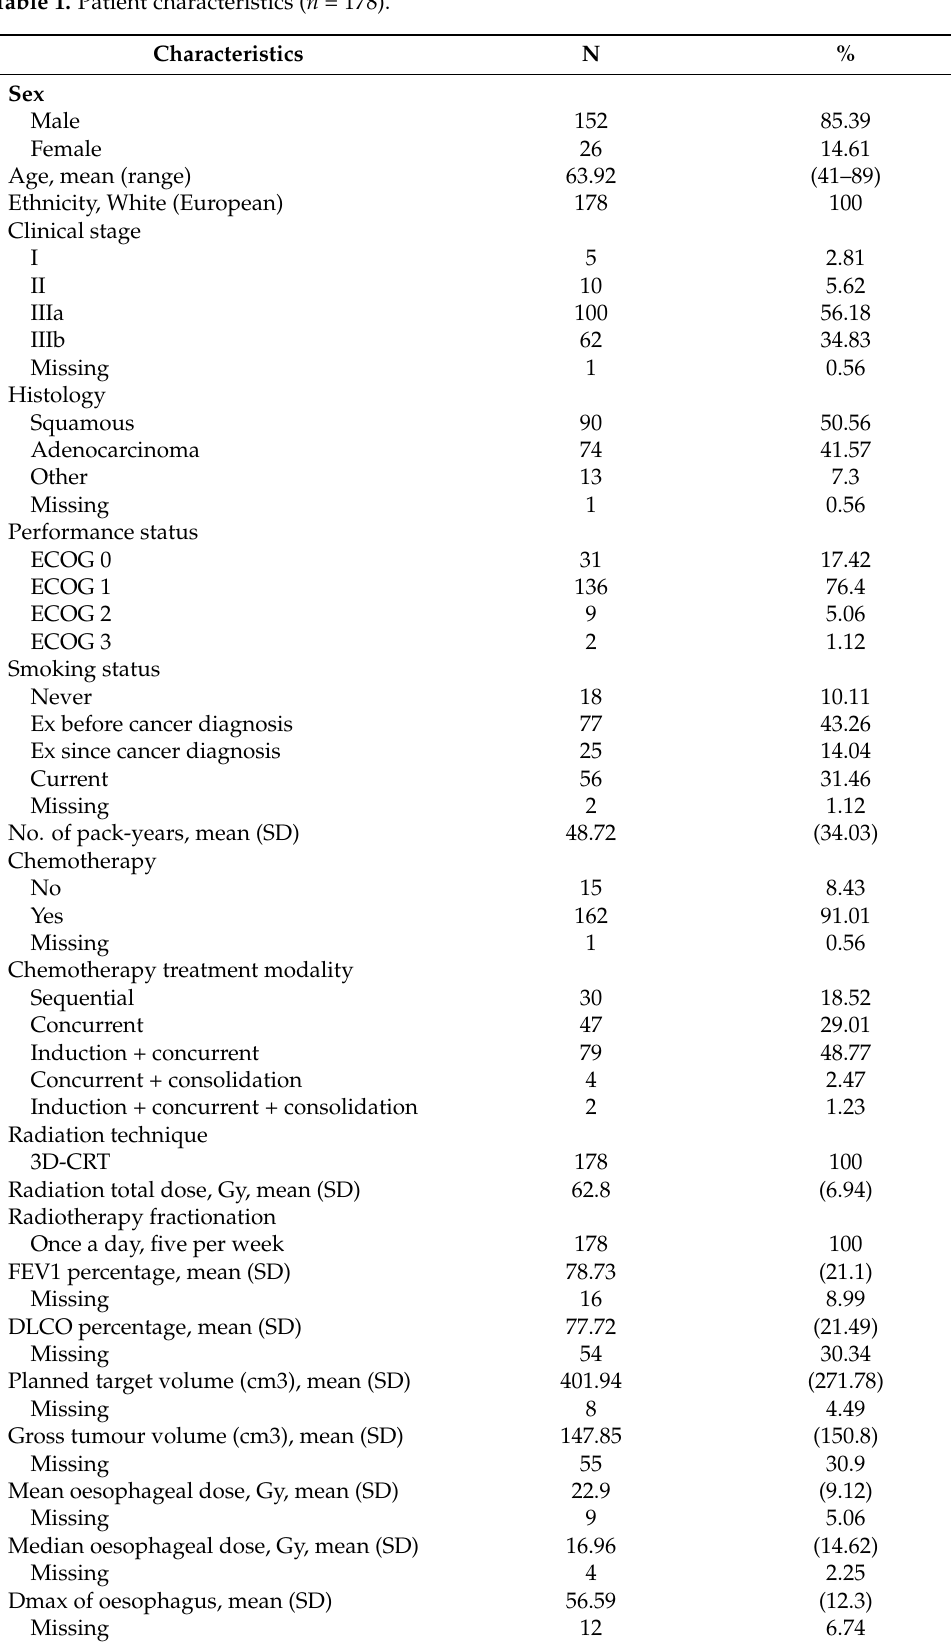
Table 1. Patient characteristics ( n =